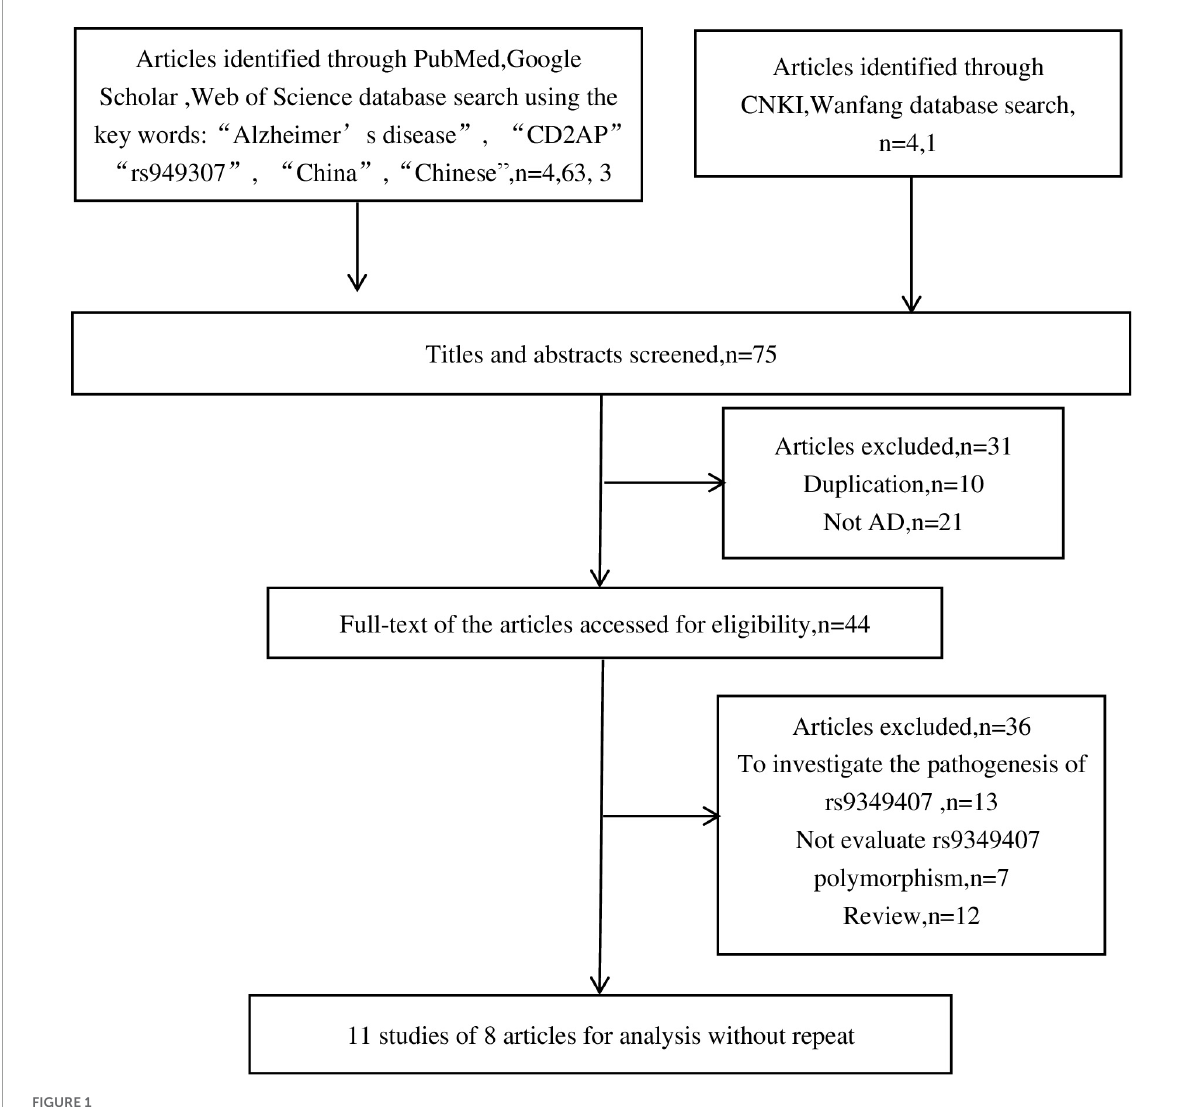
FIGURE1 Flowchart of studies excluded or included in this